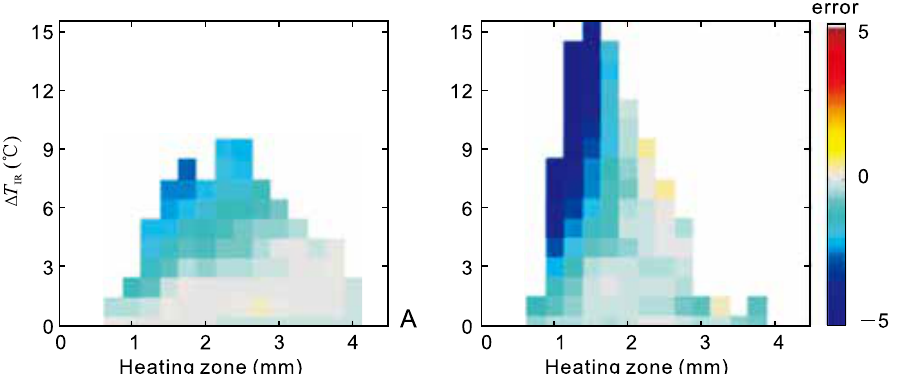
Figure 3 Color-coded error plotted as a function of size of heating zone and ∆T IR using datasets from (A) tissue-mimicking and (B) fat-mimicking phantom